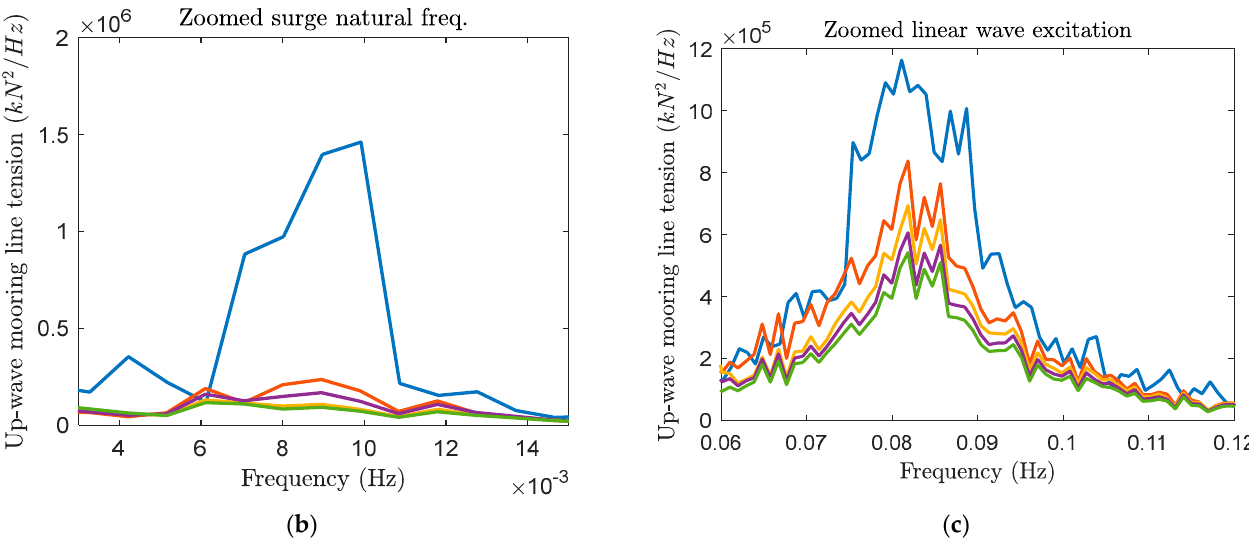
Figure 8. LC3.3 up-wave mooring line tension power spectral density (PSD): ( a ) full spectrum view; ( b ) spectrum zoomed near surge natural frequency; ( c ) spectrum zoomed near linear wave excita- tion.